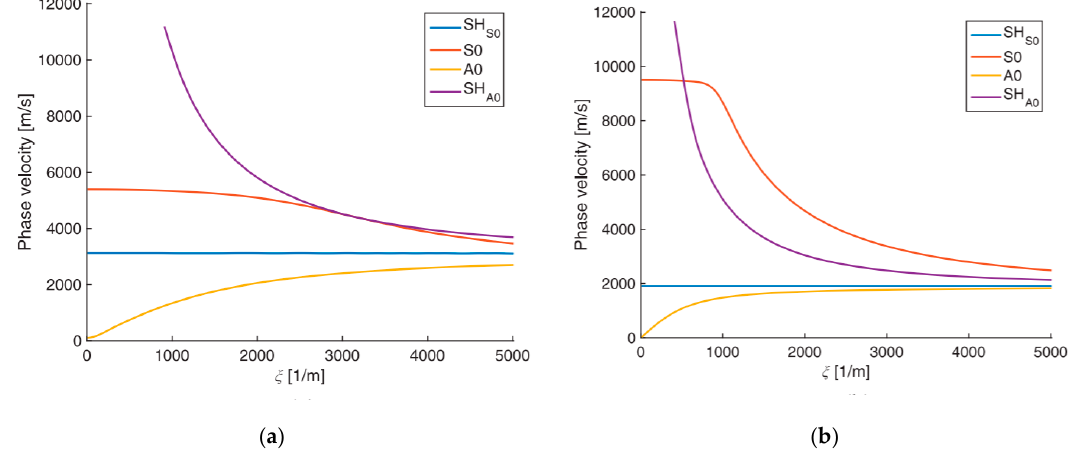
Figure 4. Dispersion curves (phase velocity vs wavenumber) of a 1-mm thick plate: ( a ) isotropic aluminum alloy; ( b ) orthotropic transversely isotropic CFRP [40]. aluminum alloy; ( b ) orthotropic transversely isotropic CFRP